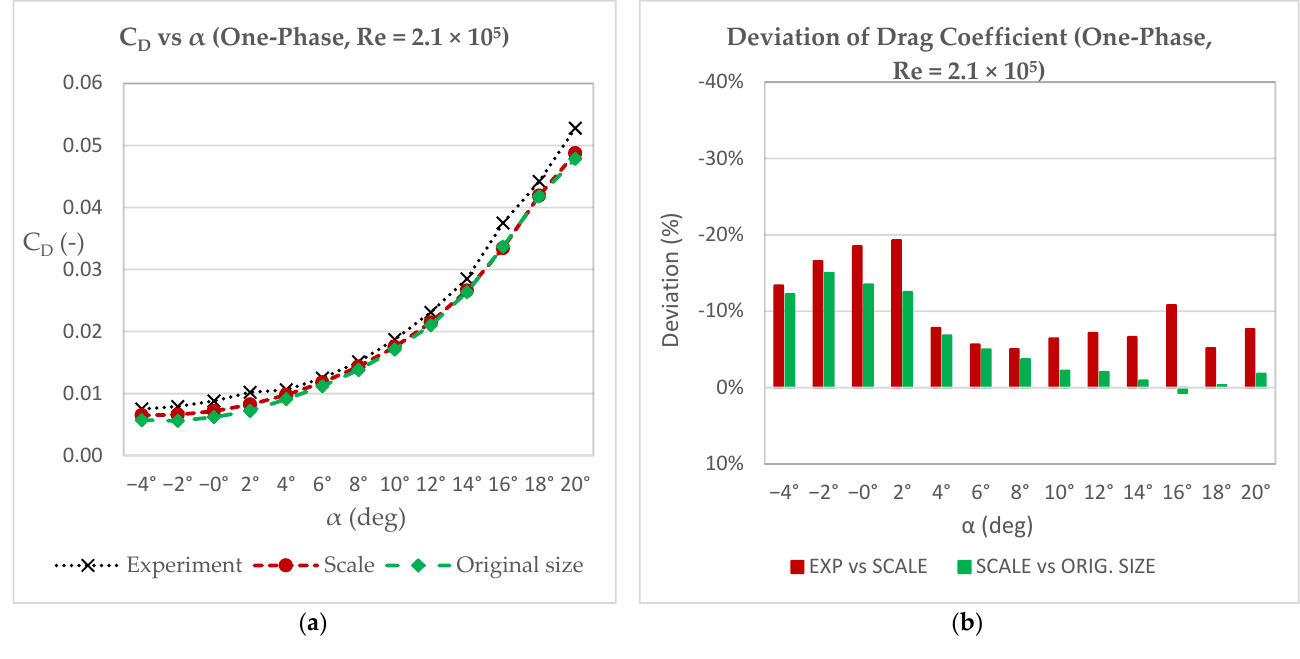
Figure 7. One-phase flow: ( a ) lift coefficient of wing, from numerical simulations of original model and downscaled model, as well as from wind-tunnel experiment; ( b ) deviation of lift coefficient between experiment and downscaled model simulation and between original and downscaled model simulation.